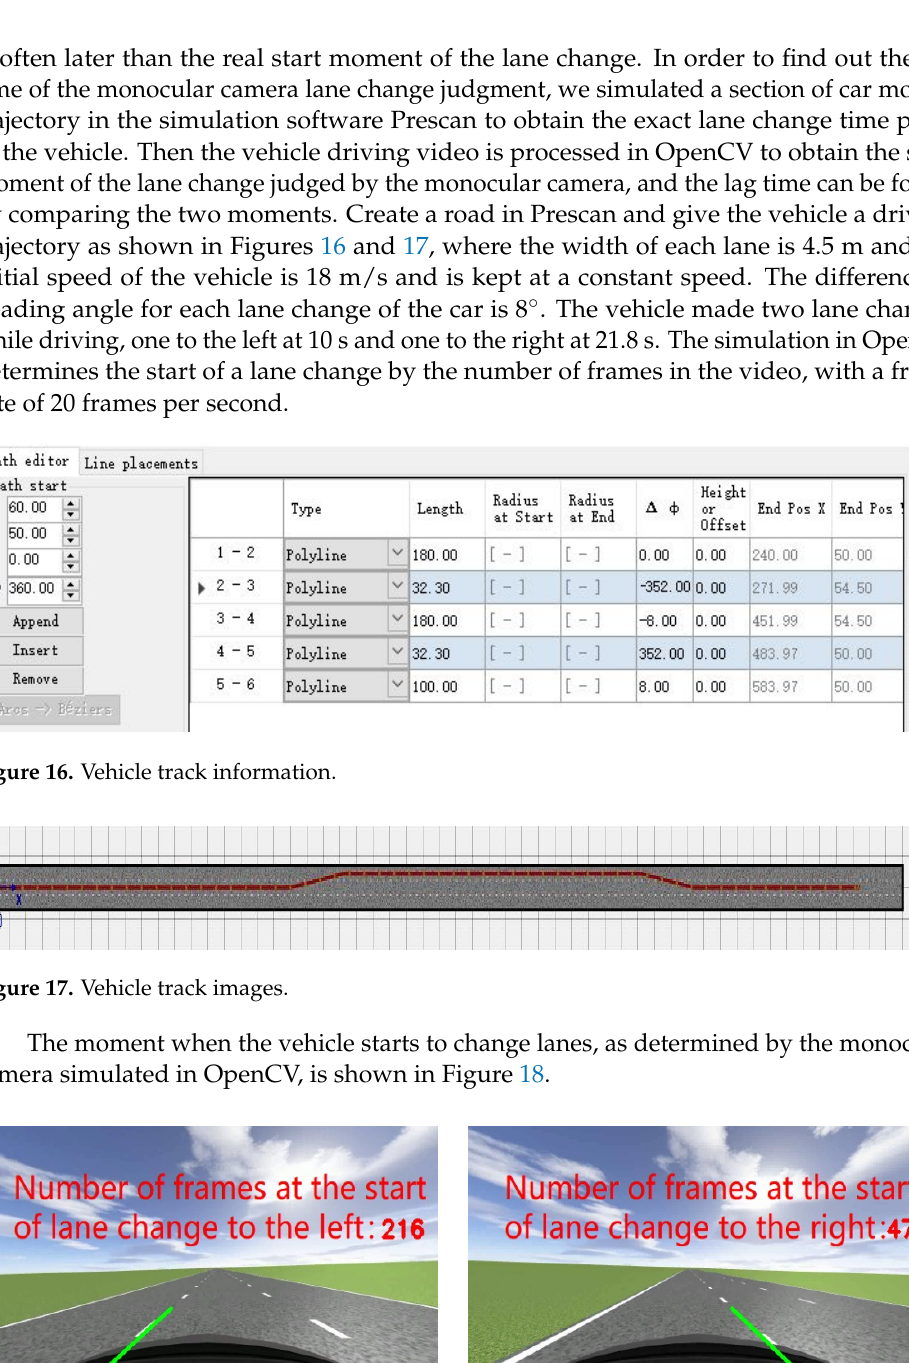
Figure 15. Images of the start and end moments of the vehicle lane change to the right: ( a ) Image of the start moment of the vehicle lane change to the right; ( b ) Image of the end moment of the vehicle lane change to the right.